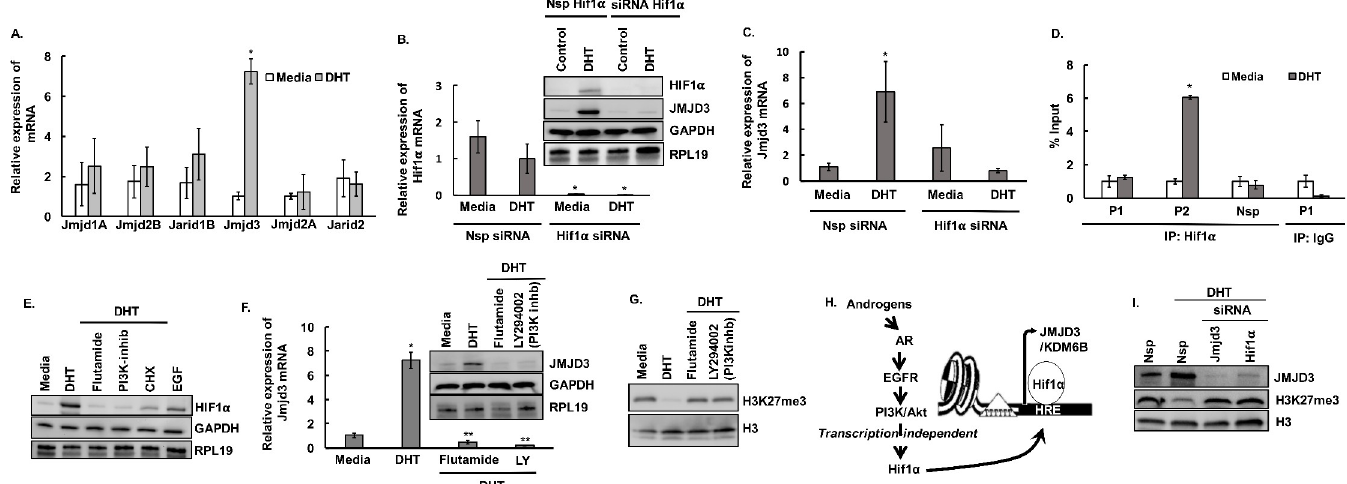
Fig 3. Androgens through HIF1 α regulate JMJD3 expression. A: Relative expression of Jumonji histone demethylase mRNA levels by quantitative PCR in mouse primary GC cultures treated with media containing vehicle (control) or DHT (25nM for 24h). Data are displayed as mean ± SEM (n = 3 experiments, for each experiment GCs isolated from 5 mice were pooled together) and normalized to Rpl19 ( � P � 0.05, vs media). B: siRNA-mediated knockdown of Hif1 α in mouse primary GC cultures. C: Effect of siRNA-mediated knockdown of Hif1 α on Jmjd3 mRNA levels in mouse primary GC cultures treated with media containing vehicle (control) or DHT. Data are displayed as mean ± SEM (n = 3 experiments, for each experiment GCs isolated from 5 mice were pooled together) and normalized to Rpl19 ( � P � 0.05, vs media). D: Anti-HIF1 α ChIP-assay in mouse primary GC cultures treated with media containing vehicle (control) or DHT (25nM for 24h) showing HIF1 α binding to two (P1/P2) HRE sequences (-0.2/+4.2Kb from TSS) on Jmjd3 promoter region. IgG represents non-specific antibody and “Nsp” represents non-specific primers. Values represent percentage input. Data are displayed as mean ± SEM (n = 3 experiments, for each experiment GCs isolated from 10 mice were pooled together) and � P � 0.05, vs media. E: HIF1 α protein levels in mouse primary GC cultures treated with media containing vehicle (control) or DHT (25nM for 24h) in presence of flutamide (AR inhibitor, 100nM), LY294002 (PI3K inhibitor, 10 μ M) or cycloheximide (CHX, a protein translational inhibitor, 1 μ M). Epidermal Growth Factor, EGF (20ng/ml) was used as a positive control. F and G: Relative expression of Jmjd3 mRNA and protein levels (F) and H3K27me3 levels (G) in mouse primary GC cultures treated with media containing vehicle (control) or DHT (25nM for 24h) in presence of flutamide (AR inhibitor, 100nM) and LY294002 (PI3K inhibitor, 10 μ M). Data are displayed as mean ± SEM (n = 3 experiments, for each experiment GCs isolated from 5 mice were pooled together) and normalized to Rpl19 (P � 0.05, � vs media and �� vs DHT). H: Proposed model of androgen-induced translation-dependent increase in HIF1 α protein levels and its role in Jmjd3 expression. I: Effect of siRNA-mediated knockdown of Hif1 α and Jmjd3 on H3K27me3 levels in mouse primary GC cultures treated with media containing vehicle (control) or DHT (25nM for 24h).